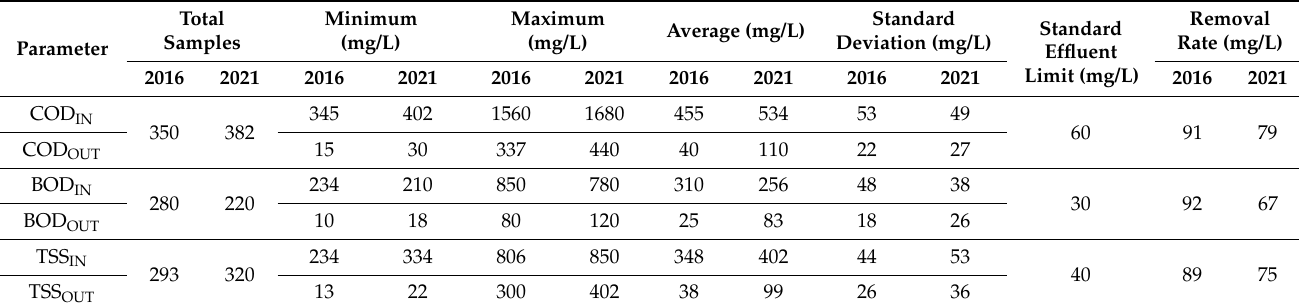
Table 4. WWTP parameters with removal rate for 2016 and 2021.